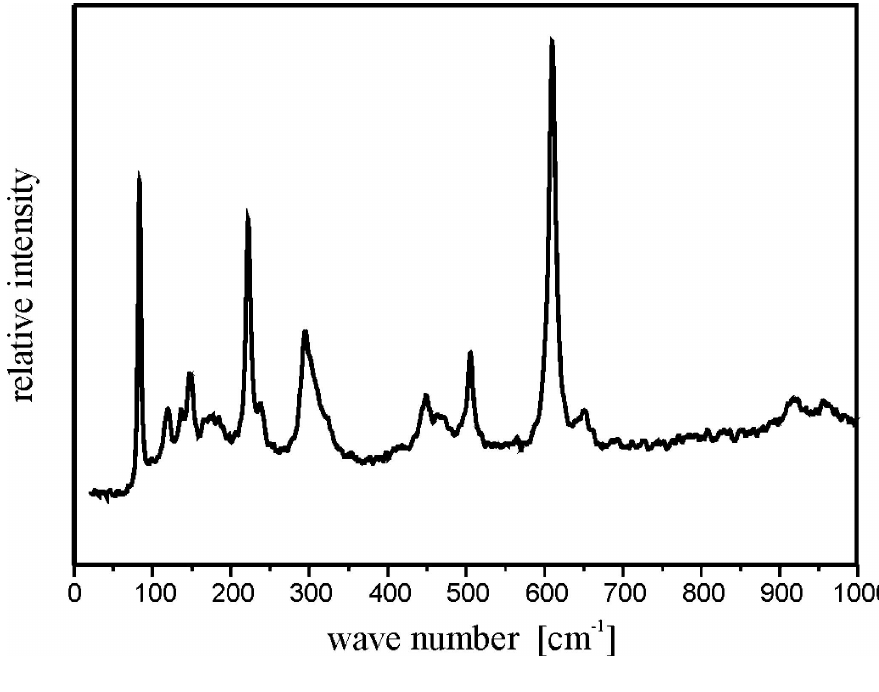
Figure 3 Raman spectrum of K dipotassium di- µ -hydrogenphosphato-bis[aquaplatinum(III)]( Pt — Pt ) Crystal data K [Pt (HPO 2 2 = 888.32 M r